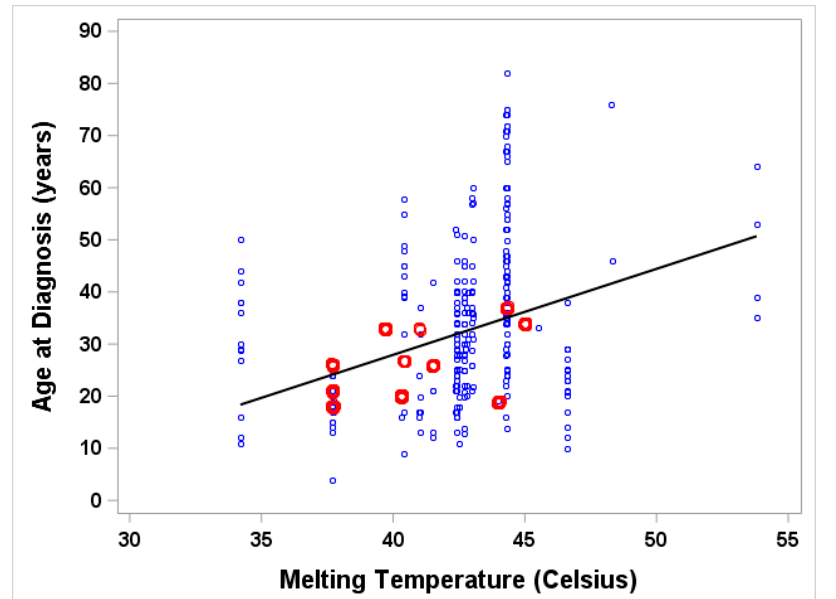
Figure 2. Plot of age at diagnosis versus the respective myocilin melting temperatures. Known individuals are blue; unknown individual ages at diagnosis are red. Pearson correlation coefficient between age of diagnosis and melting temperature is 0.37626. Linear regression of age of diagnosis (Age) on melting temperature (MT) is: Age = − 38.05 + 1.65×MT ( p < 0.0001); R-squared = 0.142; n = 458.